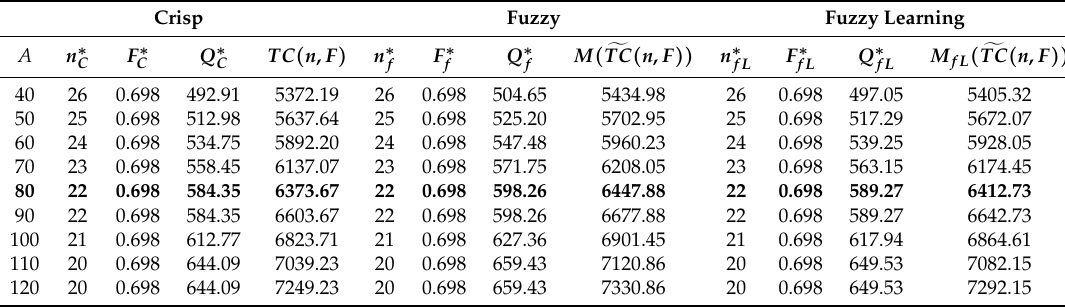
Table 2. Effect of ordering cost ( A ) on the crisp, fuzzy, and fuzzy learning